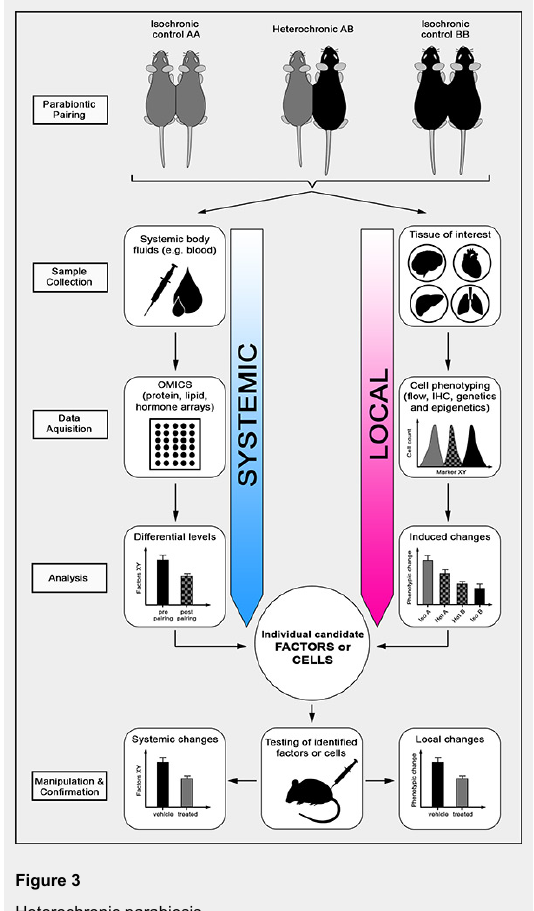
Heterochronic parabiosis. Using heterochronic pairings of young (A) and old (B) mice allows assessment of the effect of a young systemic environment on a particular local tissue of interest in the aged partner and vice versa. Isochronic pairings (AA or BB) are important controls to exclude surgery-related observations and to determine age-related changes in the systemic environment. Briefly, systemic body fluids such as blood, lymph or cerebrospinal fluid are collected, assessed with omics tools such as protein, lipid or hormone arrays and analysed for differential levels of soluble factors and after parabiosis. A particular tissue of interest is isolated, phenotypically characterised by flow cytometry, immunohistochemistry (IHC) or epi-/genetic measures and analysed for parabiosis-induced phenotypic changes. The integration of these data leads to the identification of individual candidate factors or cells that can subsequently be tested in a suitable mouse model.